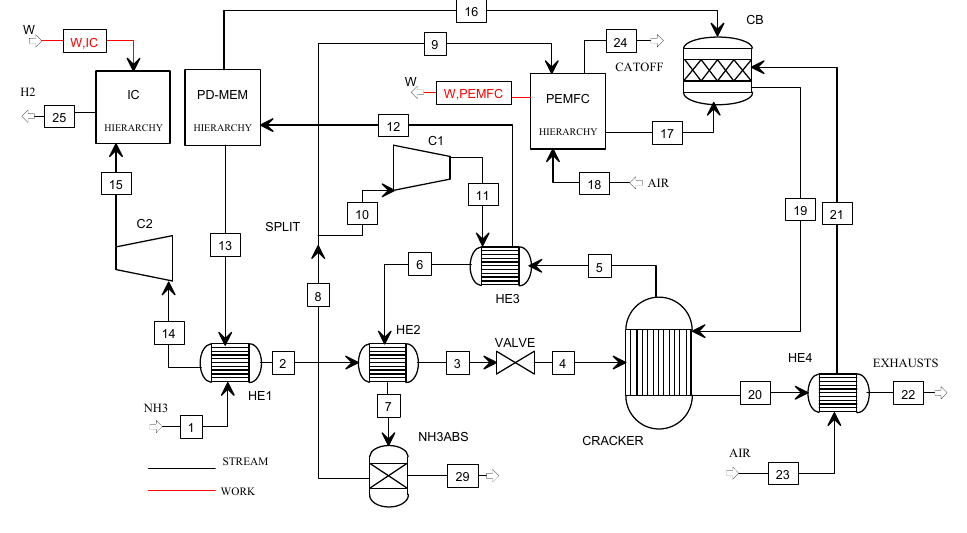
Figure 3. Flowsheet of the NH3_PEMFC model.